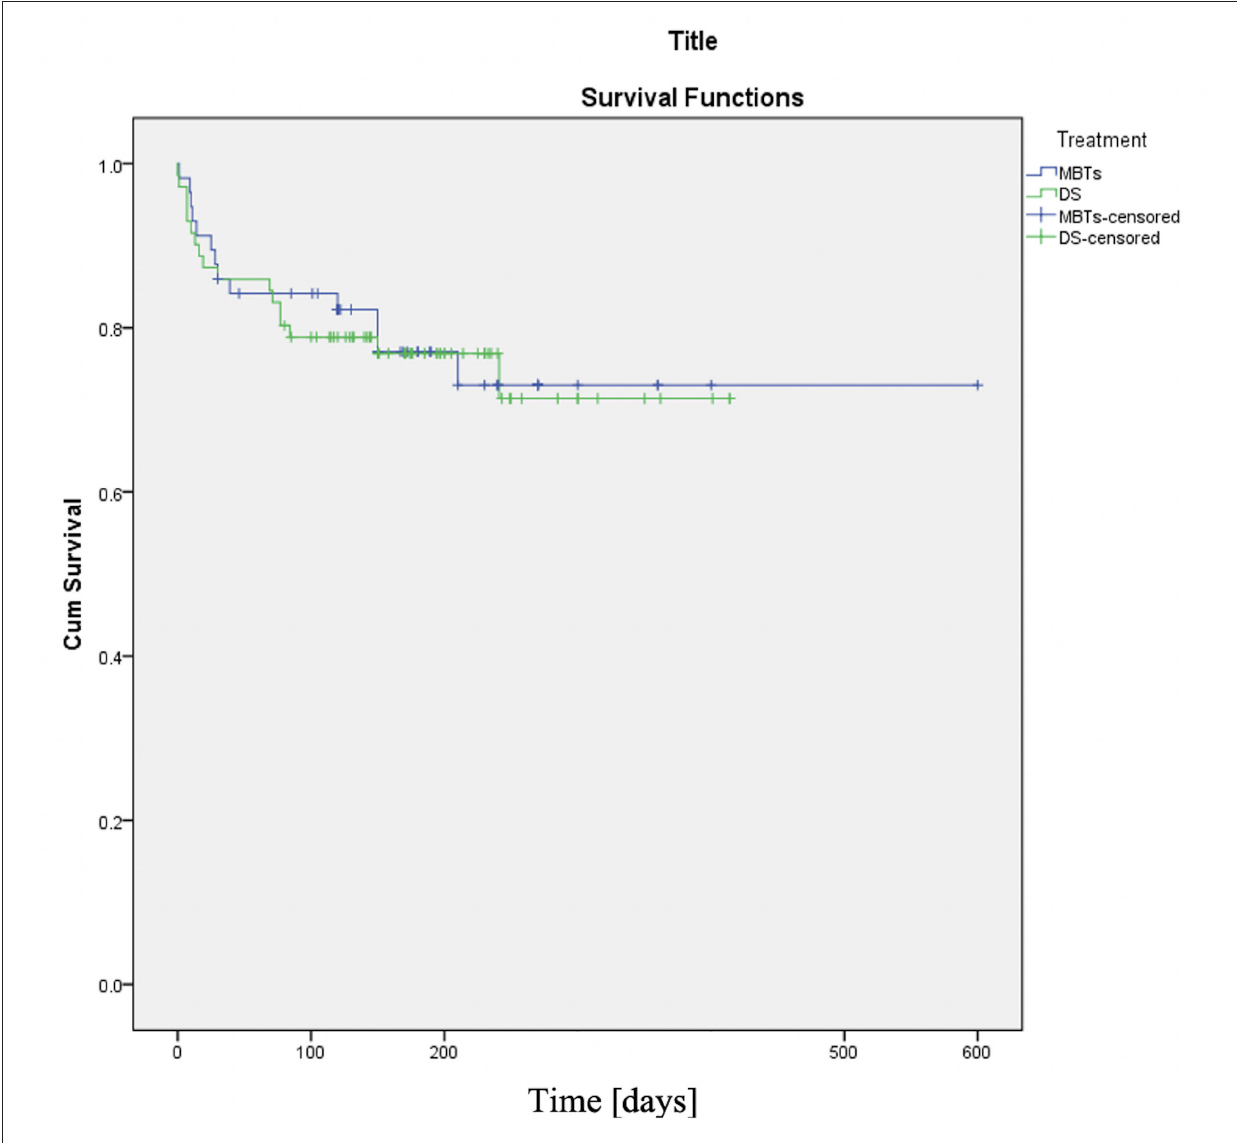
FIGURE 1 | Kaplan-Meier curve (DS vs. MBTs). The two procedures showed the same decay over the whole population while reaching the primary endpoint. X-axis time since procedures is indicated in